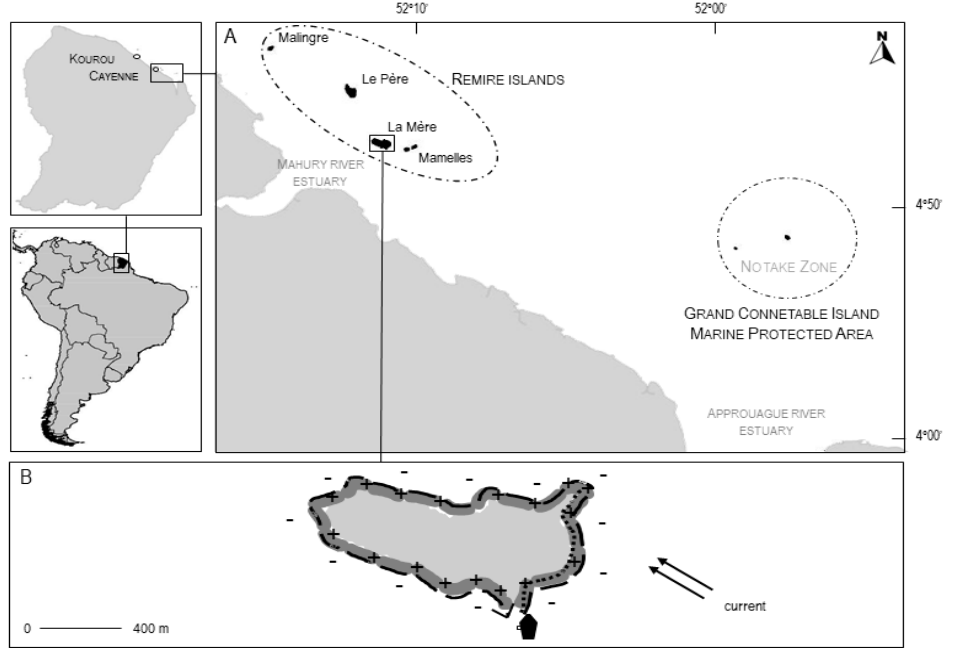
Figure 1. ( A ) Marine rocky islands of eastern French Guiana where goliath groupers ( Epinephelus itajara ) were sampled acoustically and by fishing. ( B ) La Mère island (Rémire islands) showing acoustic camera deployment from the boat (dash line) and fishing locations (dotted line). Dark gray zone indicates the field of view of the acoustic camera (+) indicates the presence of rock, ( − ) the presence of mud and arrows indicate the prevailing marine current.